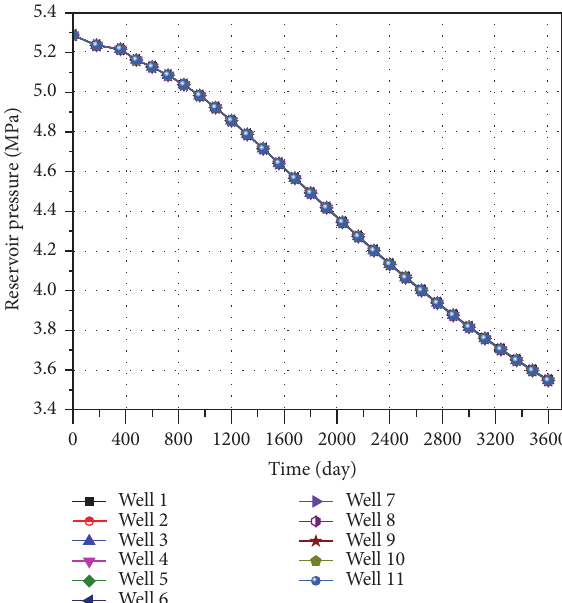
Figure 7: Daily well gas productions.